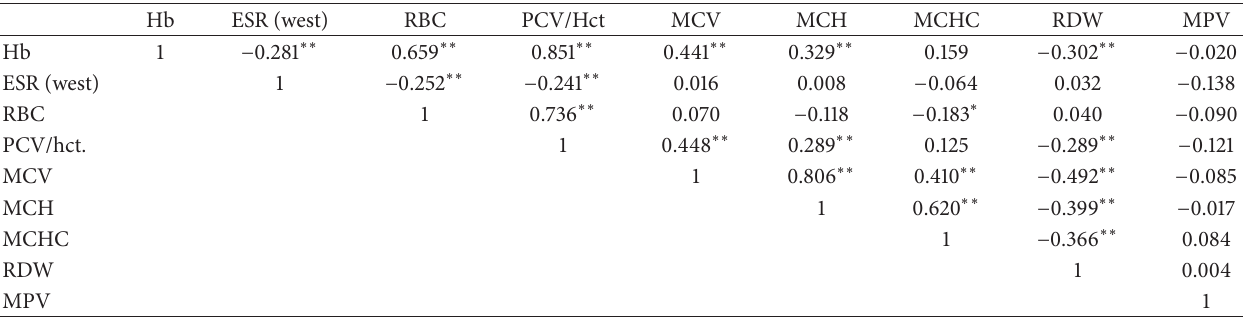
Table 4: Showing correlation among hematologic and biochemical variables in iron deficiency anemia